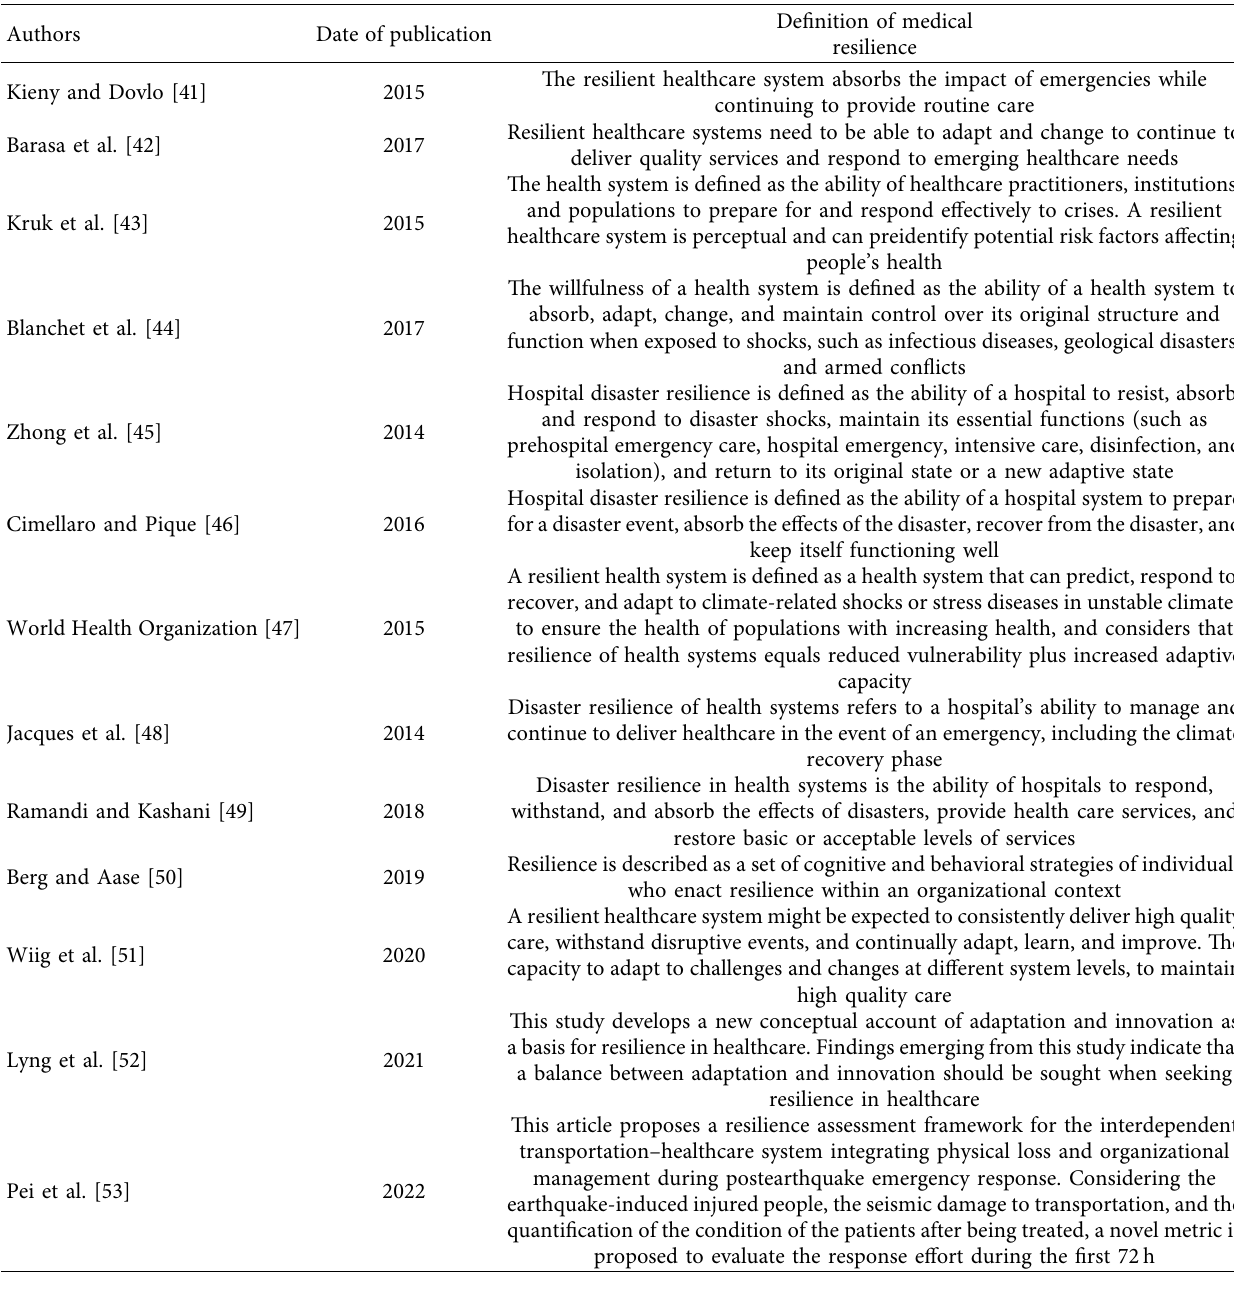
Table 2: Defnition of healthcare system